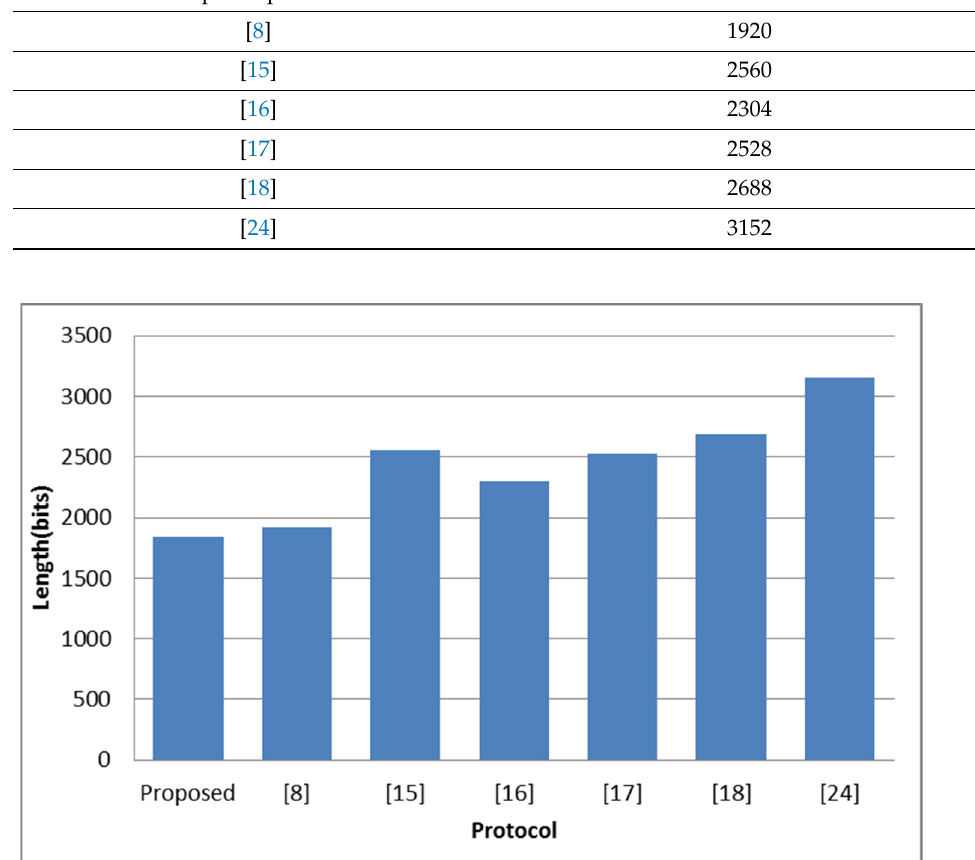
Figure 10. Communication overhead comparison.